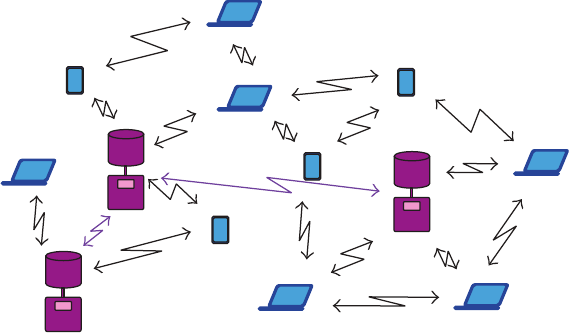
Figure 2: Two-tier MANET: purple tier 1 portable nodes and blue tier 2 mobile hand-held devices.